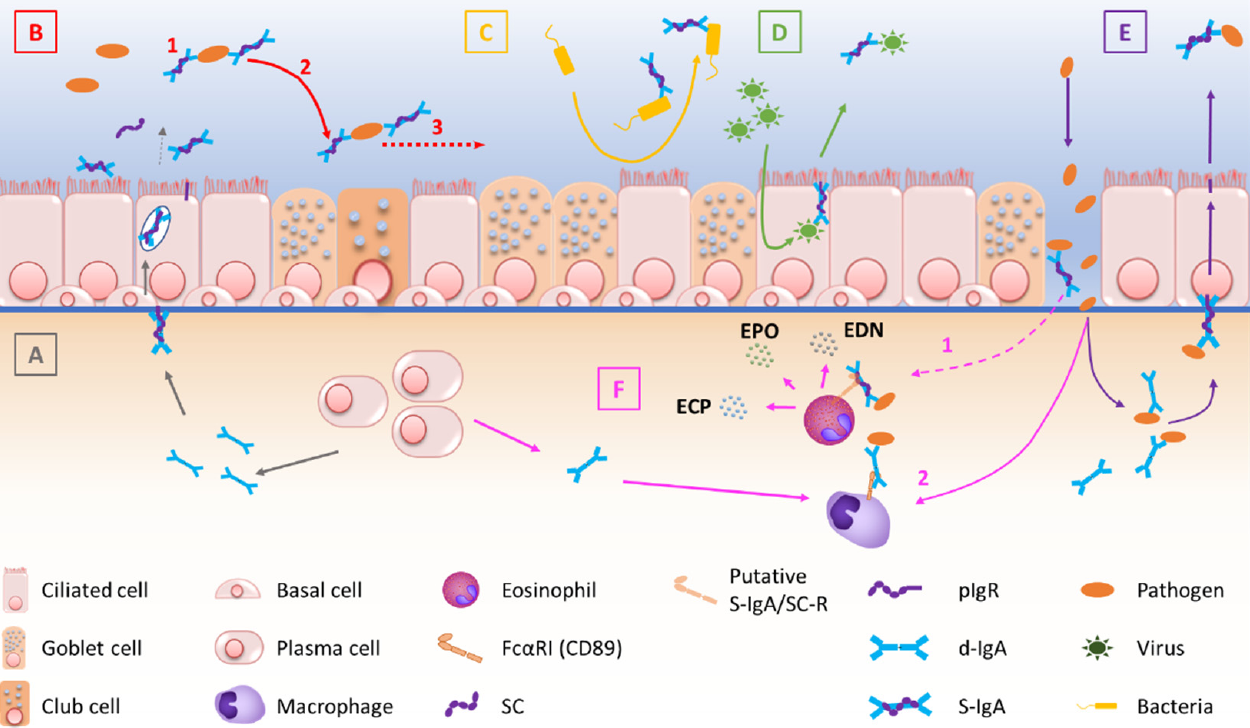
Figure 1. Schematic description of the multiple functions of IgA and the pIgR/S-IgA system at mucosal surfaces. ( A ) pIgR-mediated endosomal transcytosis of d-IgA, produced by submucosal B cells. ( B ) S-IgA-driven immune exclusion, including agglutination (1), entrapment of immune com- plexes (2) and clearance of trapped pathogens (3). ( C ) Inhibition of bacterial adherence to the muco- sal epithelium. ( D ) Intraepithelial neutralization of penetrating viral antigens. ( E ) pIgR-mediated elimination of subepithelial immune complexes, after immune exclusion of pathogens by subepi- thelial d-IgA. ( F ) (1) S-IgA-induced degranulation of eosinophils resulting from binding of S-IgA to